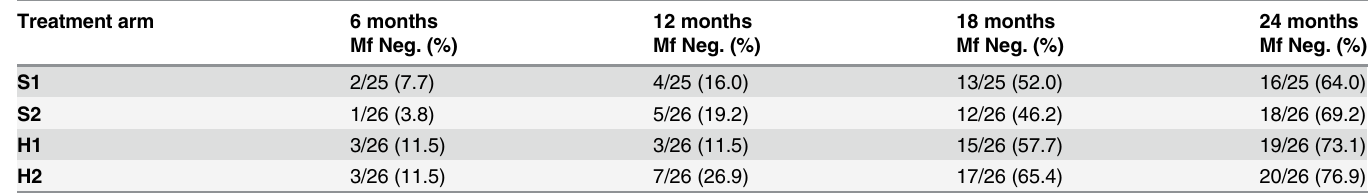
Table 2. Mf clearance at different follow up points in the four treatment arms. Treatment arm